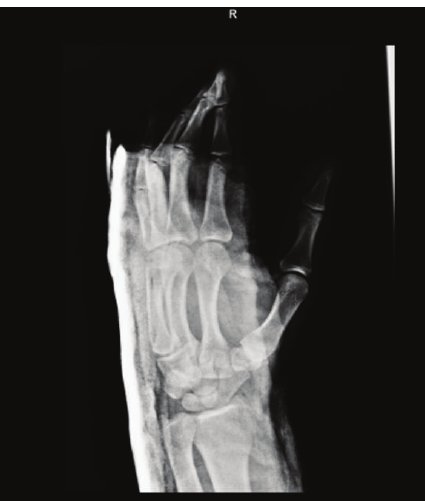
Figure 3: After reduction X-ray: optimal reduction, no more signs of